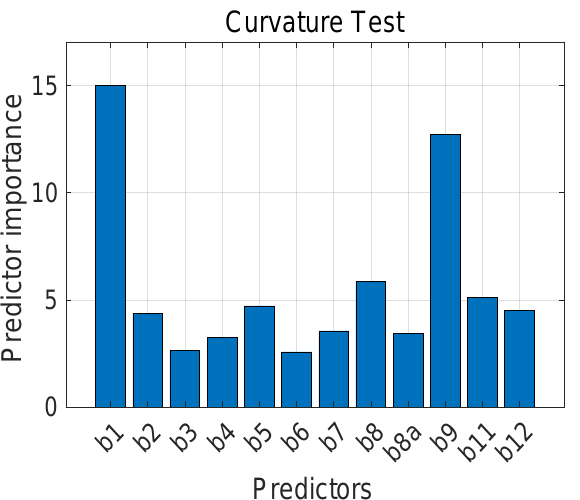
Figure 10. Curvature test result for the features in the random forest classifier with Bayesian opti-